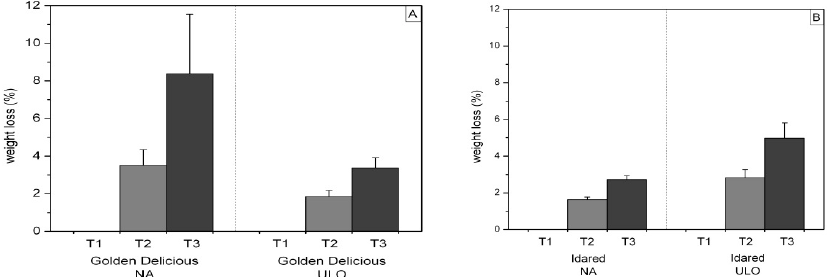
Figure 1. Impact of storage type on weight loss (%) in ( A ) ‘Golden Delicious’ and ( B ) ‘Idared’ apples after 10 (T2) and 20 days (T3) of shelf life at 20 ℃ . Values represent mean ± standard deviation (S.D.) of measurements made on 20 fruit per storage type and shelf life period.